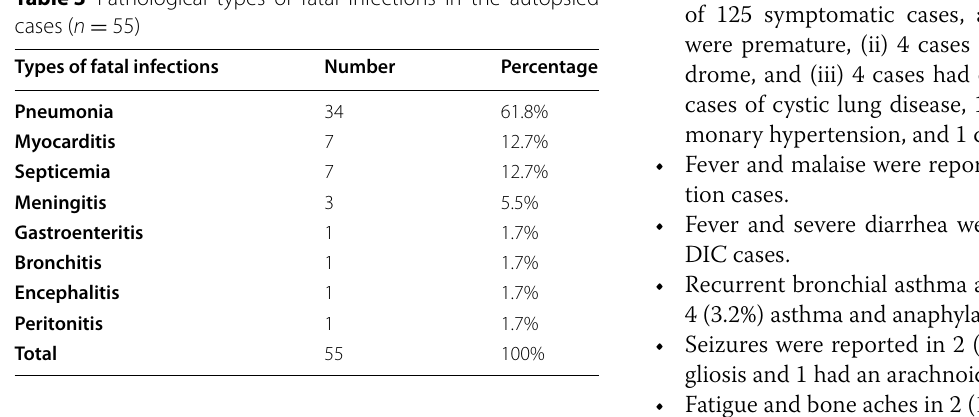
Table 3 Pathological types of fatal infections in the autopsied